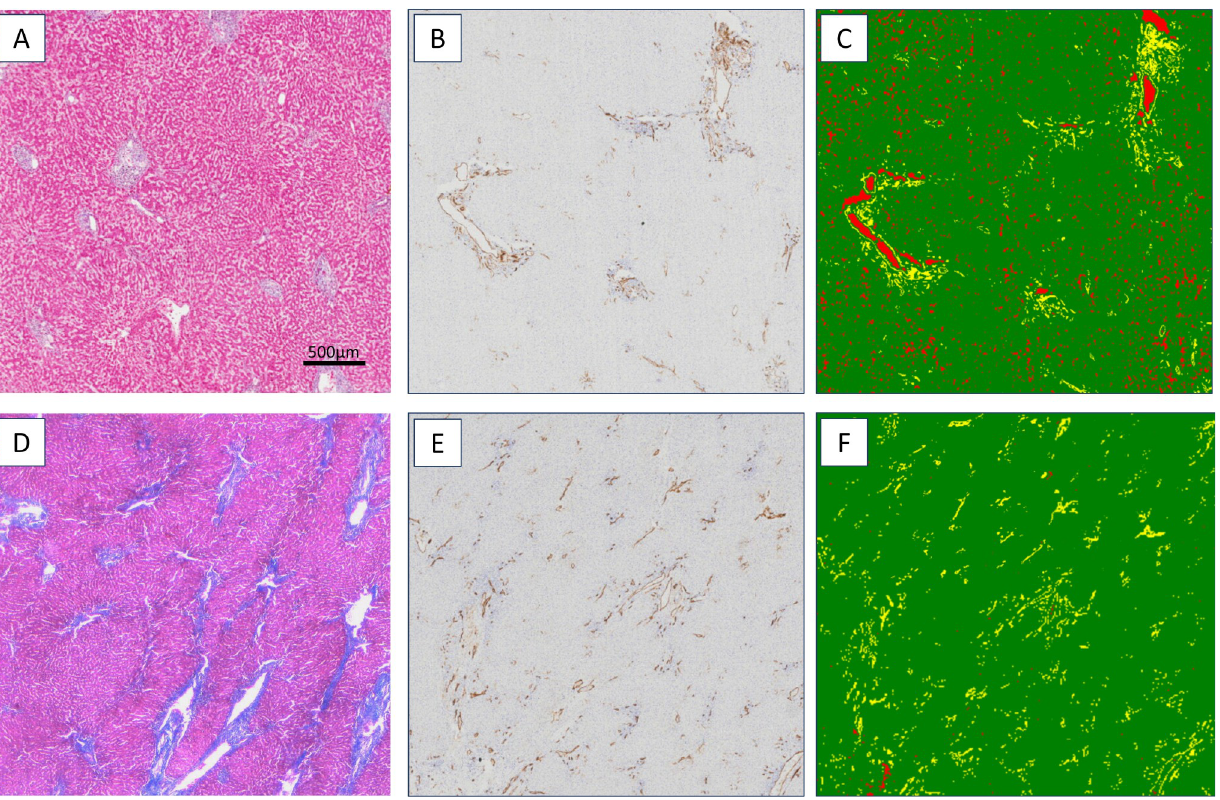
Fig 3. CD34 image analysis. A-C: Case with no HRC features: Trichrome stain (A); CD34 IHC (B); � HALO classifier image analysis (C). D-F: Case with 7 HRC features: Trichrome (D); CD34 IHC (E); � HALO classifier image analysis (F). � HALO classifier image analysis key: Hepatocytes (green), CD34 + sinusoids (yellow), blank space (red). Scale bar applies to all